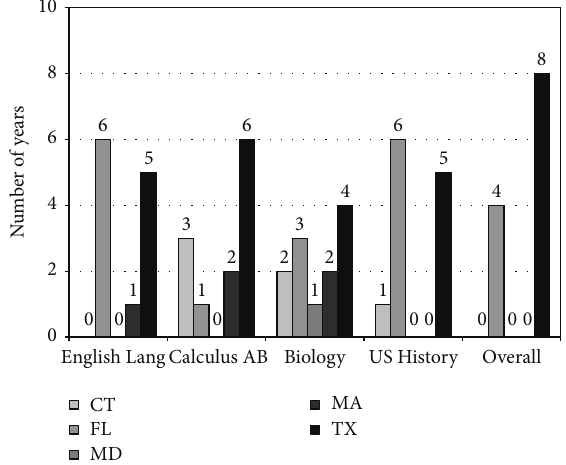
Figure 2: A summary of the number of years in which Black male students in Connecticut, Florida, Maryland, Massachusetts, and Texas achieved the highest percentage of students who earned an AP exam of 3 or lower between 2001 and